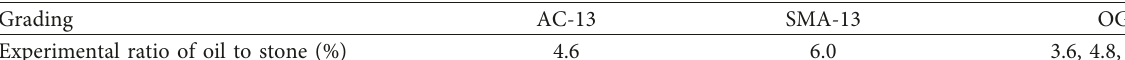
Table 6: Design of asphalt content.